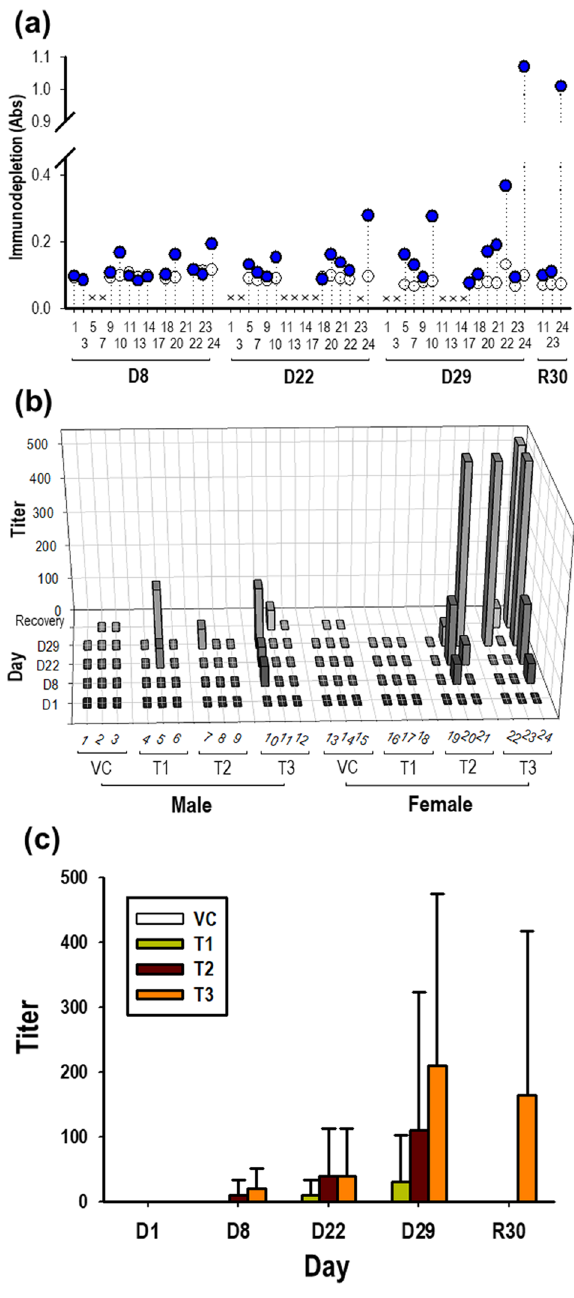
Figure 7. Measurement of ADAs, representing anti-GX-G3 antibodies, in monkeys subjected to 4-week repeated subcutaneous injection with GX-G3 followed by a 4-week recovery period. Monkeys were separated into 4 injection subgroups: VC (vehicle control), T1 (1 mg/kg GX-G3), T2 (3 mg/kg GX-G3), and T3 (10 mg/ kg GX-G3). ADA levels in monkey sera were measured using the method validated in the present study. ( a ) Immuno-competition assays were performed to discriminate between true and false positive samples. True positivity for GX-G3 specificity was identified based on a greater than 30% difference 30% in absorbance between the non-treated and GX-G3-treated samples. ( b ) Monkey serum samples determined to be true positives were prepared as serial three-fold dilutions beginning from 20-fold. The antibody titer of each sample was expressed as the highest fold-dilution displaying a positive response (absorbance value > normalized NCO value). ( c ) The mean antibody titer of each group was arithmetically calculated. VC, vehicle control group; D1, D8, D22 and D29, dosing days 1, 8, 22 and 29, respectively; R30, recovery day